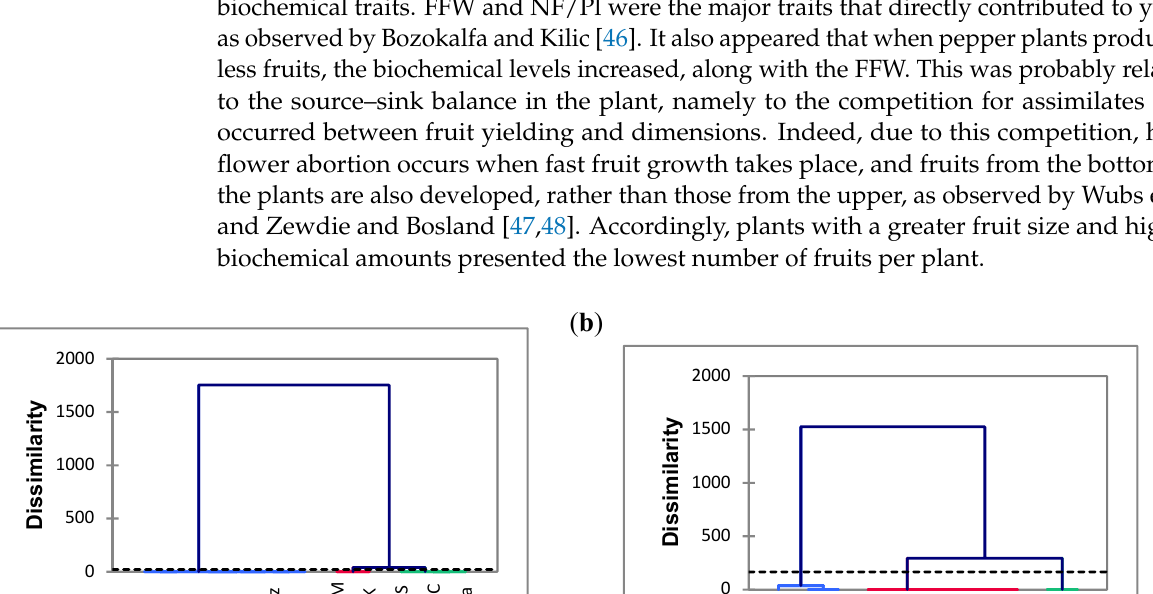
Figure 4. Principal component analysis based on phytochemical compounds and antioxidant activity (by DPPH and FRAP assays) analyzed at 10 ( a ), 25 ( b ), 40 ( c ), 55 ( d ), 70 ( e ), 85 ( f ) and 100 DAA (days after anthesis) ( g ) in the eleven Tunisian chili pepper accessions. TP: total phenol content. TF: total flavonoid content. CAP: capsaicin content. See caption to Figure 2 for the list of acronyms used for the studied accessions.